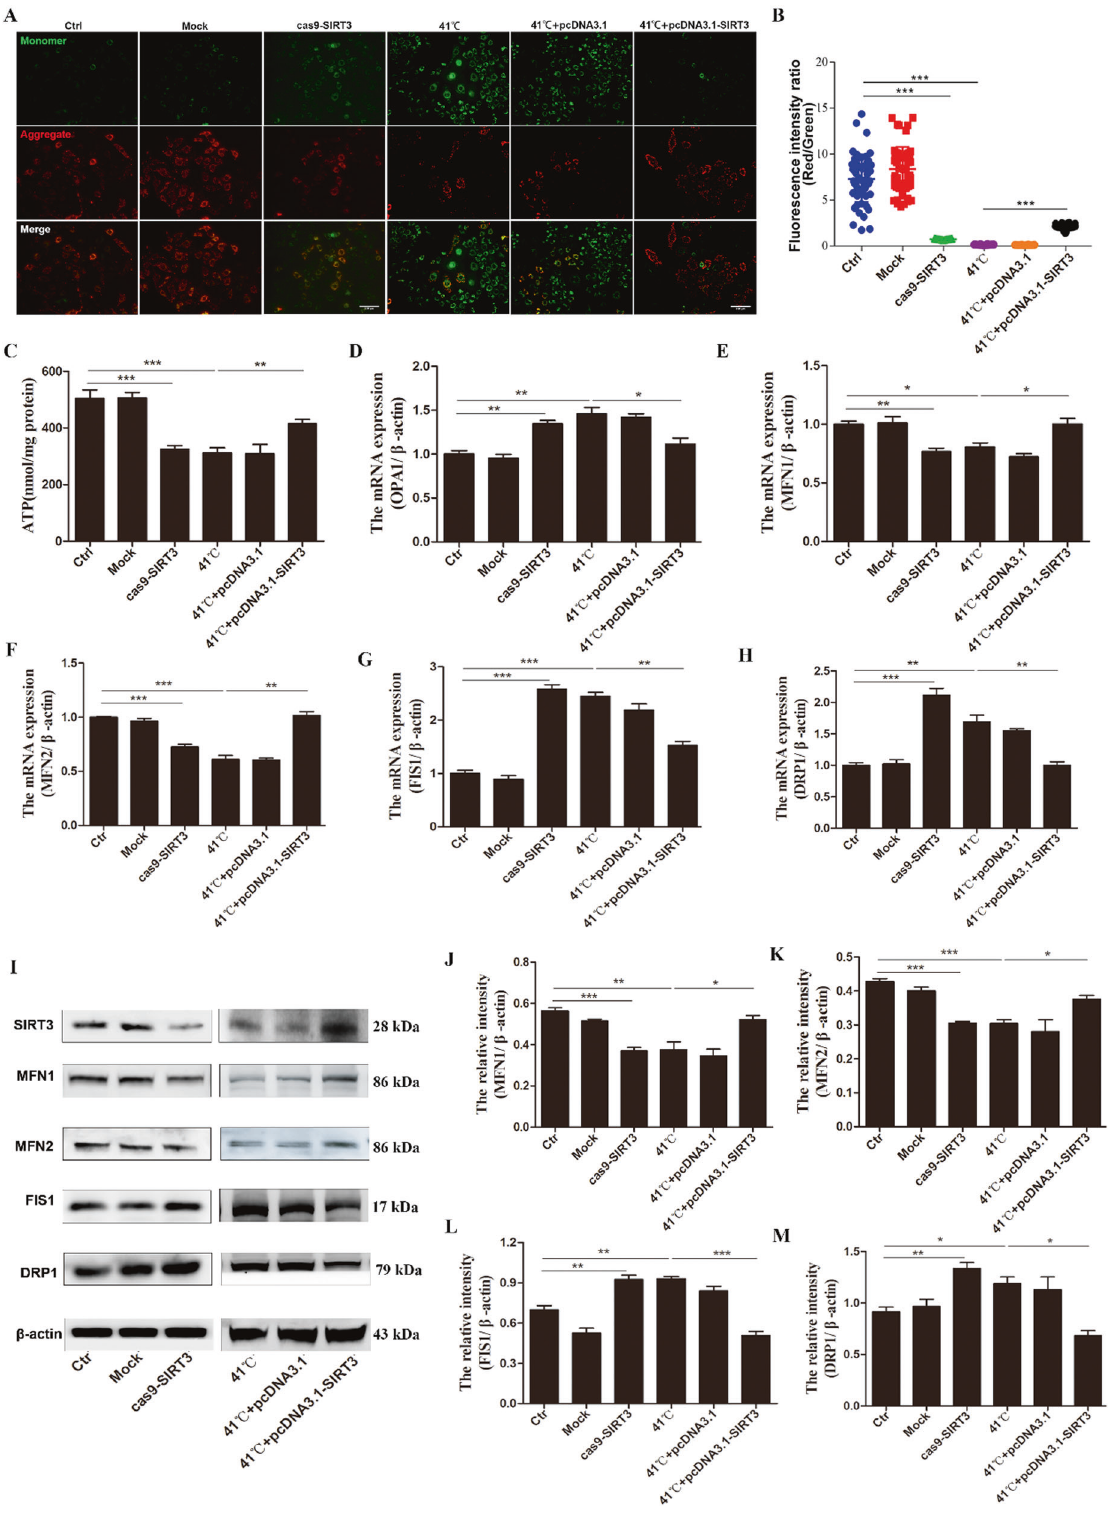
Fig. 3 SIRT3 changes the level of mitochondrial membrane potential in heat-stressed BMECs and inhibits the mitochondrial damage induced by heat stress. A Observation of the mitochondrial potential using JC-1 staining. Red: JC-1 red fl uorescence, green: JC-1 green fl uorescence, scale bar: 100 μ m. B The percentage of red/green fl uorescence intensity was quanti fi ed using Image J. C Kits were used to determine the ATP content of cells. D – H RT-qPCR was used to detect the relative mRNA expression levels of OPA1 ( D ), MFN1 ( E ), MFN2 ( F ), FIS1 ( G ), and DRP1 ( H ). I The protein levels of MFN1, MFN2, FIS1, and DRP1 were determined by western blotting. J – M The quanti fi cation of the relative protein levels (performed using Image J) is shown under the band (protein/ β -actin). Data are expressed as mean ± SEM ( n = 3), * P < 0.05; ** P < 0.01; *** P <